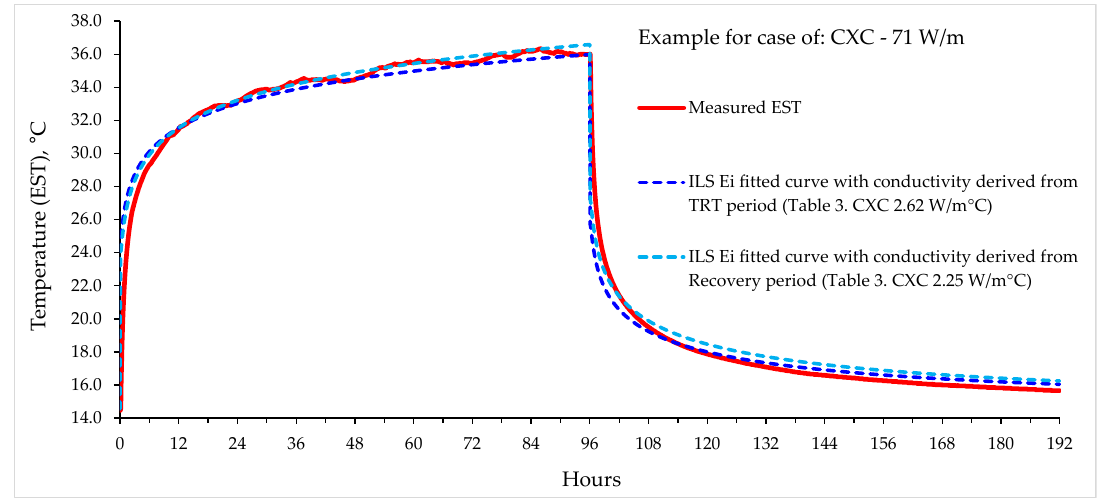
Figure 11. Example of fitting measured EST data with the infinite line source equation and two different values of thermal conductivity (the first obtained from the TRT period, and the second from the recovery period) for a case of 71 W/m and CXC setup.